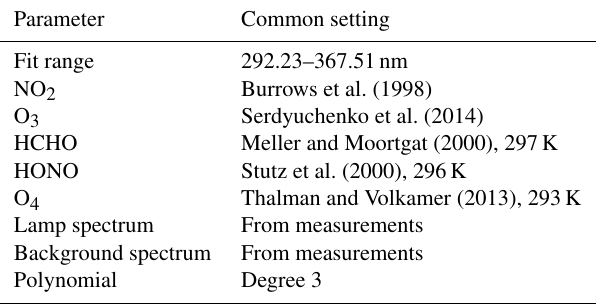
Table 4. LP-DOAS analysis